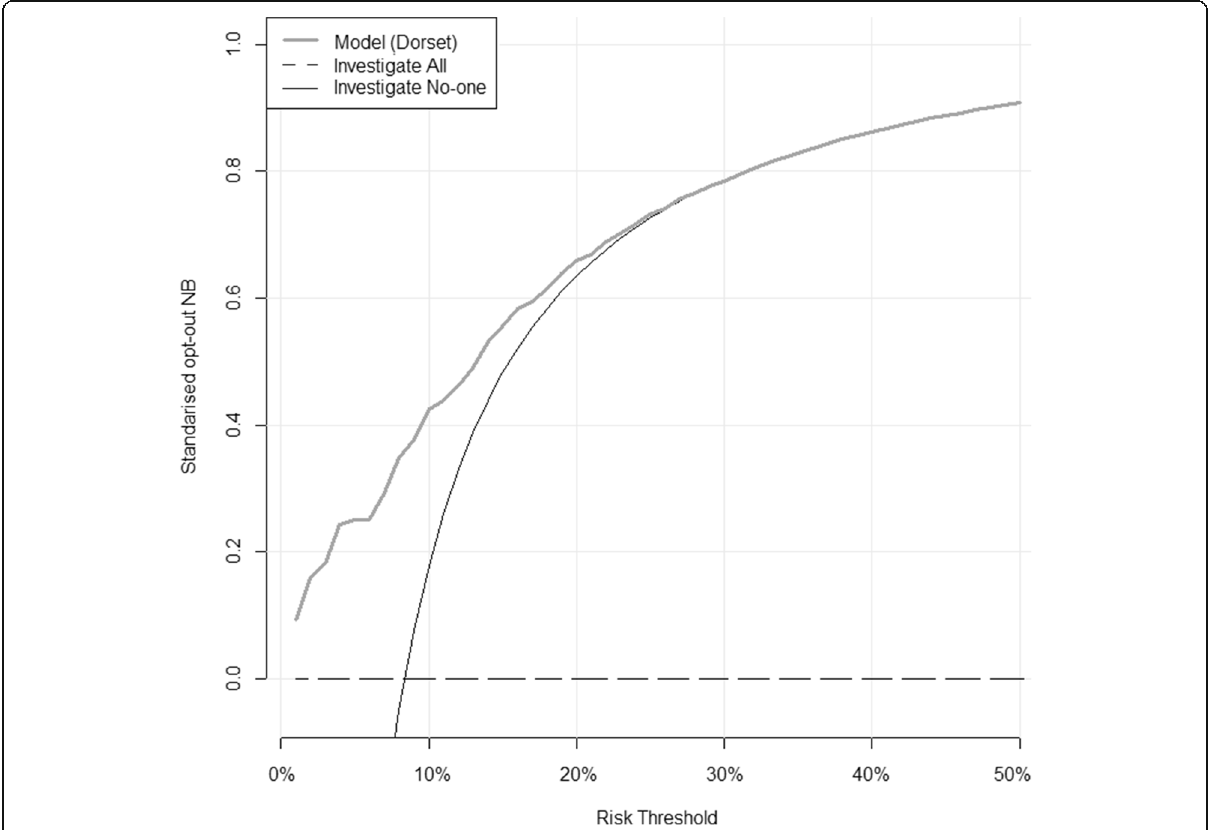
Fig. 3 Decision curve analysis for GI investigation using Dorset data. Grey line: penalised IDIOM model. Black line: investigate no-one strategy. Dashed line: investigate all strategy. The vertical axis displays standardised net benefit. The horizontal axis shows the risk